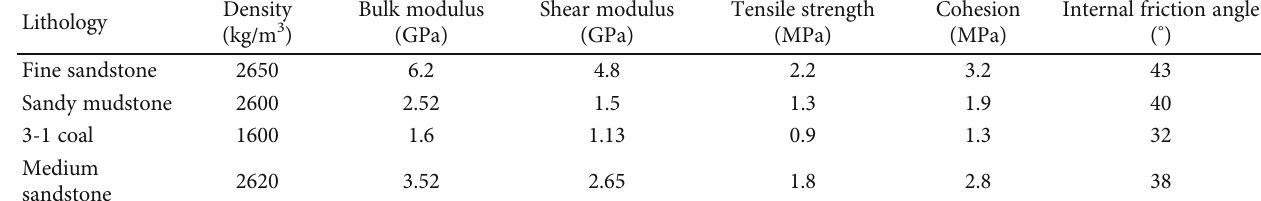
Table 2: Physico-mechanical parameters of ore-rocks.